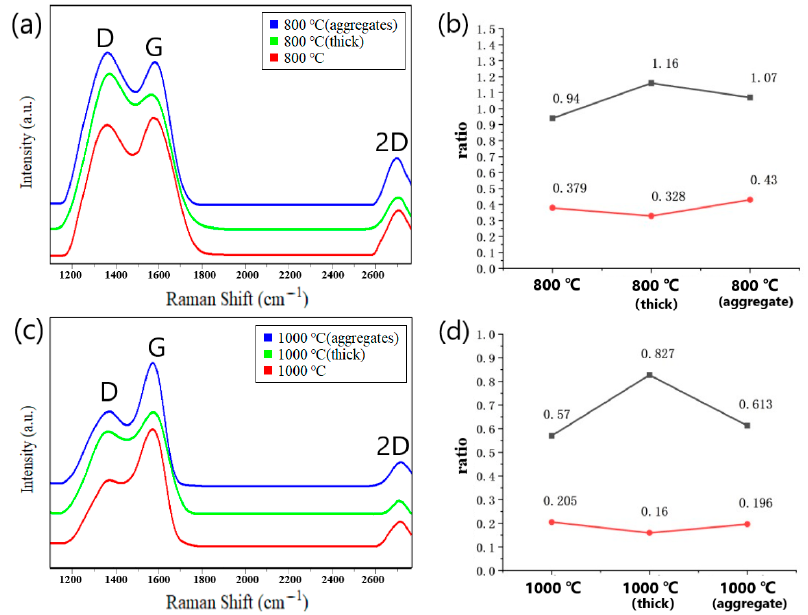
Figure 9. ( a ) Comparison of Raman spectra of the at 800 °C carbonized PDA fi lms with di ff erent morphologies (red curve corresponds to PDA fi lm prepared according to the achieved optimal parameters, green curve corresponds to PDA film with smooth surface but bigger thickness, the blue curve corresponds to PDA film with the same thickness as the red curve, but aggregates on the surface). ( b ) The ratios of I D /I G and I 2D /I G in three cases after carbonization at 800 °C; ( c ) Raman spectrum comparison after carbonization at 1000 °C. ( d ) The ratios of I D /I G and I 2D /I G in three cases after carbonization at 1000 ℃ .